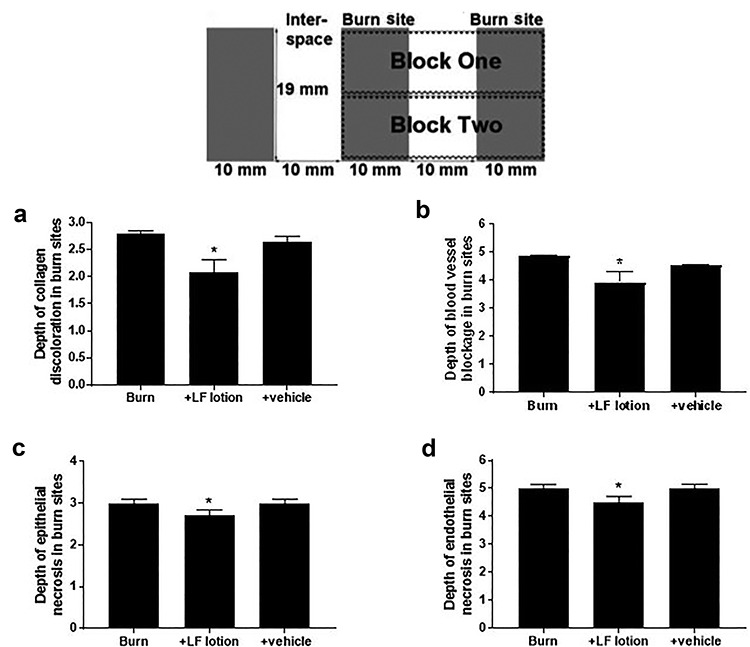
Microscopic scoring of the depth of (a) collagen discoloration, (b) blood vessel blockage, (c) epithelial cell necrosis and (d) endothelial cell death. *p < 0.05 vs. burn alone or burn plus vehicle lotion. The inset shows each sampling block that encompasses 2 burn sites and 1 inter-space from each burn area (Block1 and Block 2). LF Livionex formulation